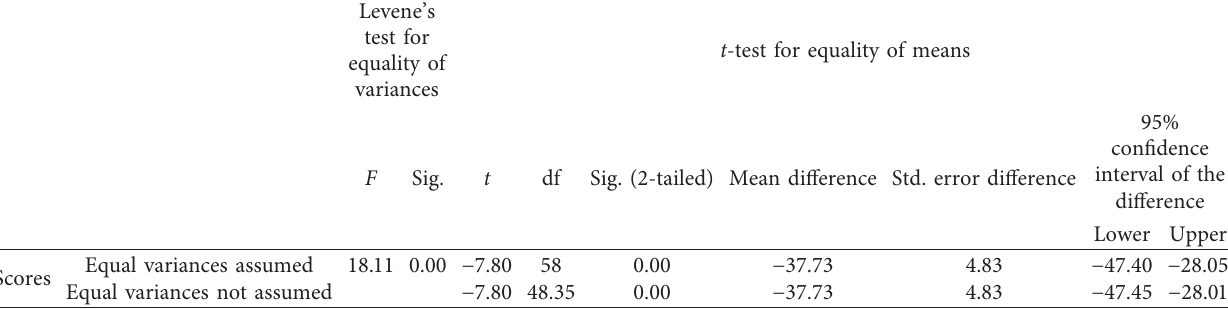
Table 8: Independent-samples t -test (reading motivation